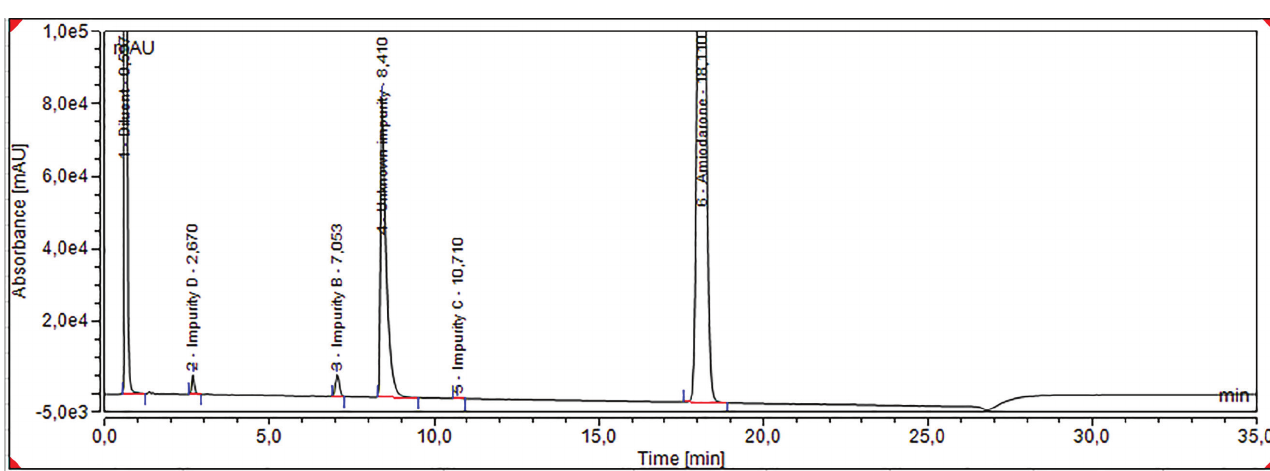
FIGURE 4 - Representative chromatogram of amiodarone hydrochloride tablets after degradation by oxidation.